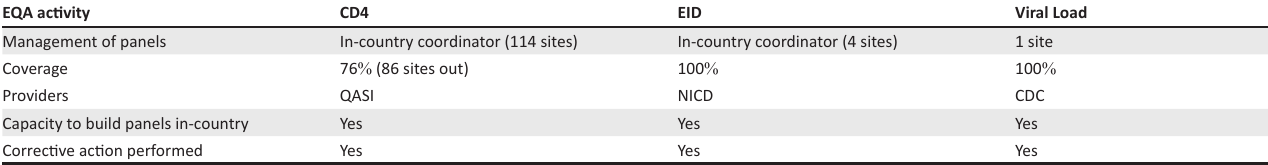
TABLE 1: Mozambique external quality assessment activities in place,